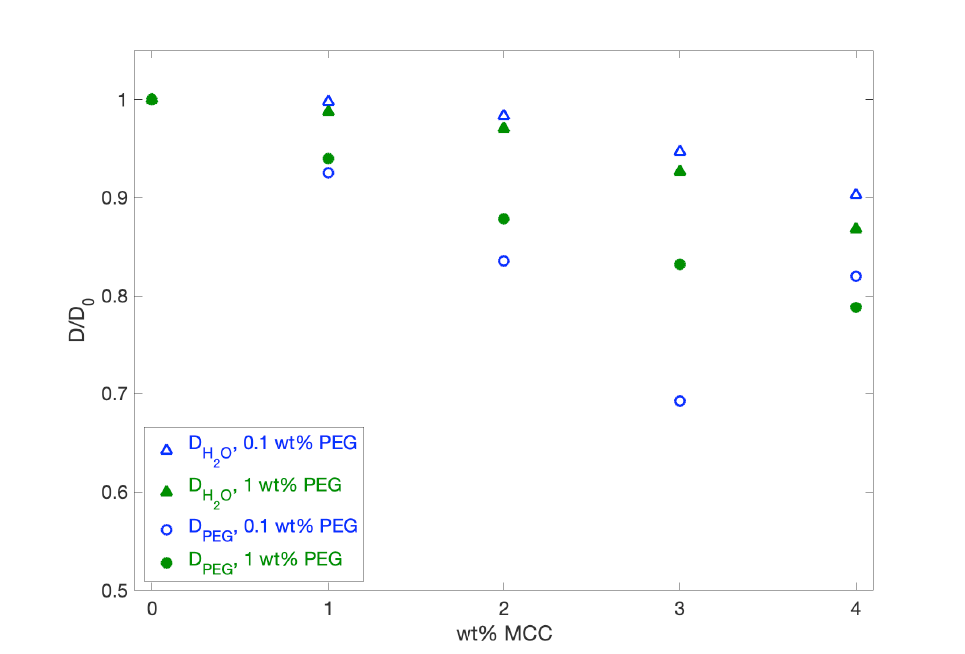
Figure 8. Diffusion coefficients D H2O and D PEG for H coefficients were measured at different MCC concentrations and divided by the diffusion in the neat solvent, D 0 . Measurements were performed for 0.1 and 1 wt % PEG-200 (blue versus green data